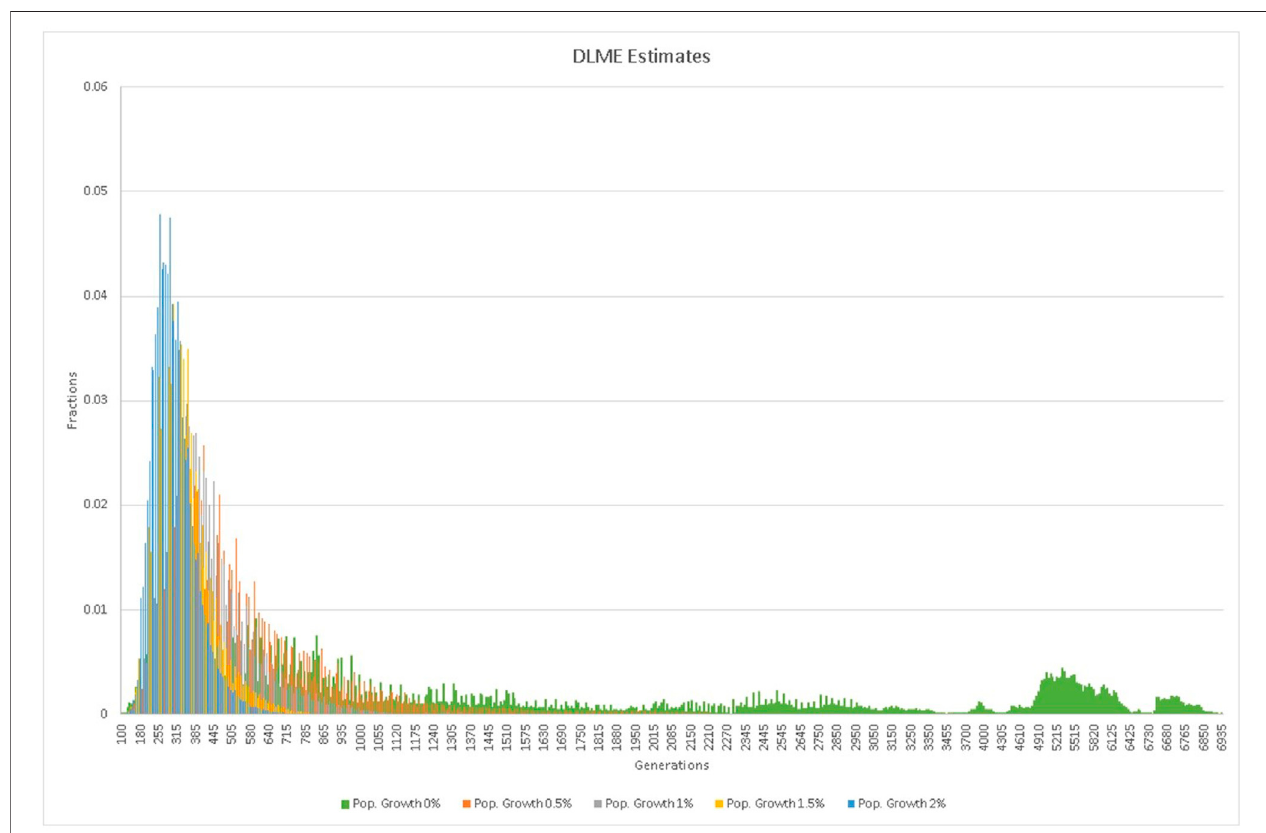
FIGURE 4 | DMLE estimates of the mutation age assuming various rates of population